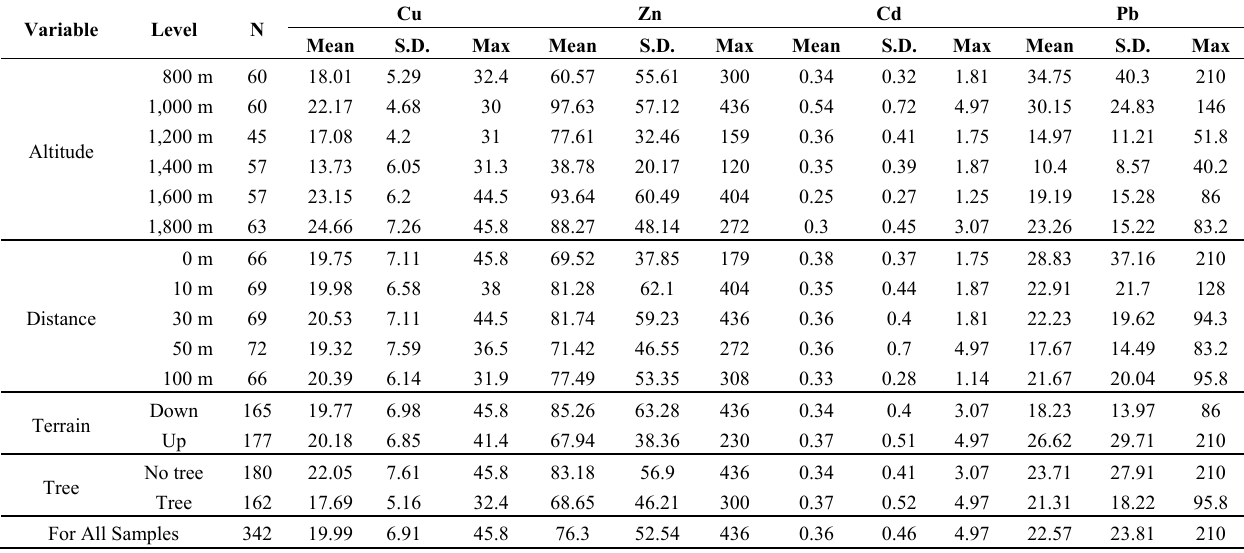
Table 3. Descriptive statistical results of heavy metal concentrations (mg/kg) in mountainous rural roadside farmland